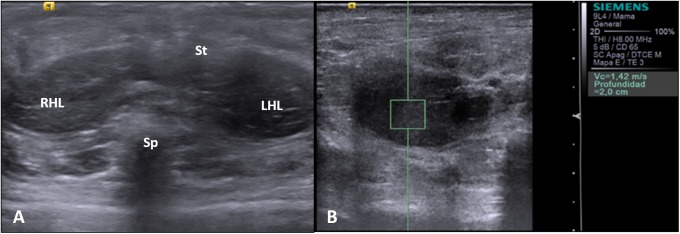
A, In vivo ultrasound image of the upper abdominal quadrants. RHL: right hepatic lobe; LHL: left hepatic lobe; St: Stomach; Sp: Spine. B, In vivo assessment using the ARFI technique.